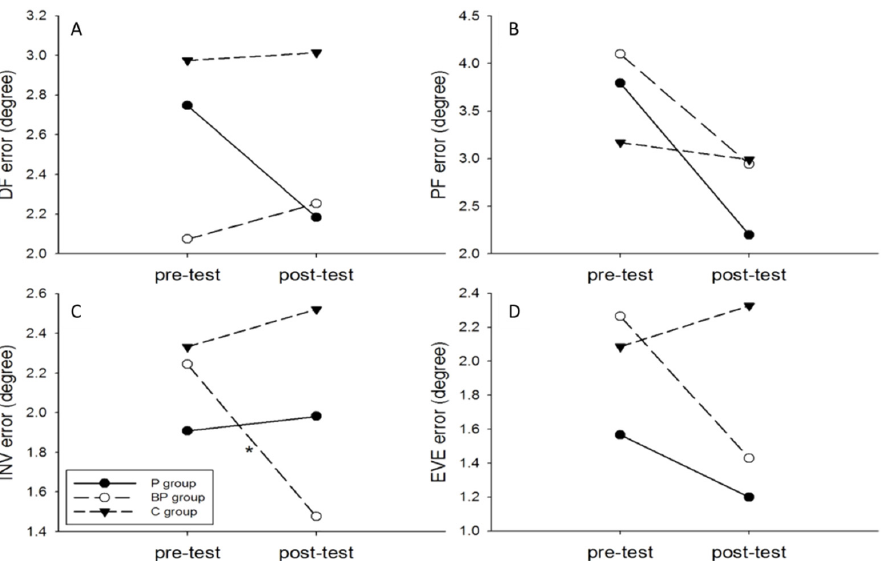
Figure 4. Absolute error values in ankle joint position: ( A ) 10 ◦ dorsiflexion (DF), ( B ) 15 ◦ plantar flexion, ( C ) 15 ◦ inversion (INV), and ( D ) 10 ◦ eversion. * p < 0.05, comparison between pre-test and